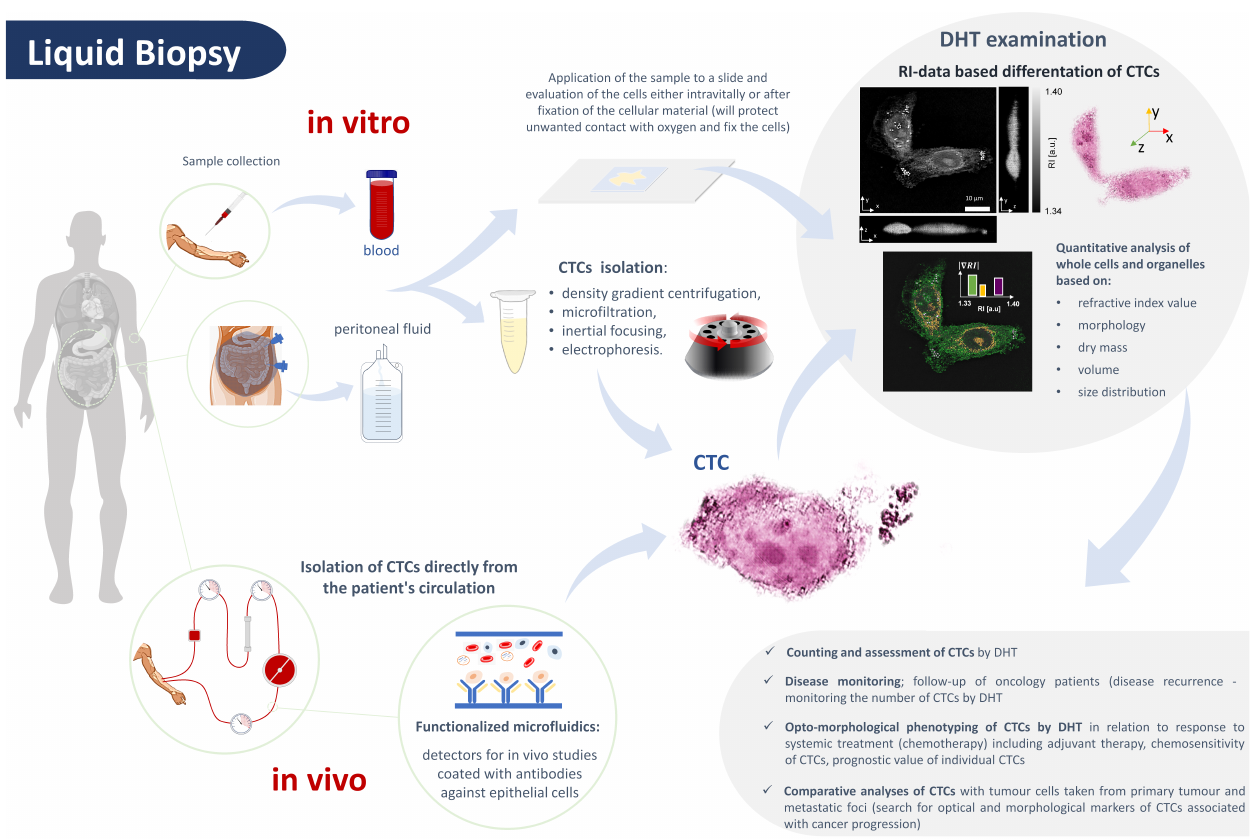
Figure 9. Possibilities of using the digital holotomography (DHT) method in the detection of circulat- ing tumor cells